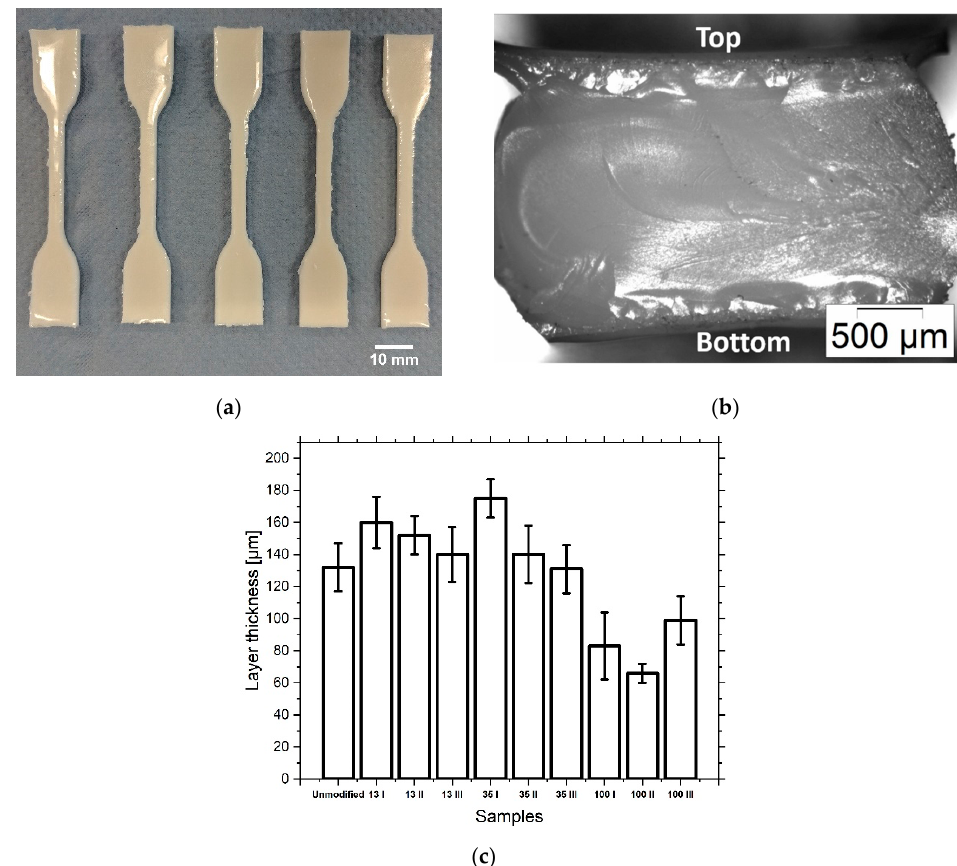
Figure 7. Printed tensile specimens of sample 100 III with 2 vol% fillers of 100 nm size ( a ). Cross-section of the specimen ( b ). The layer thickness of five subsequently printed layers with a UV curing step after their deposition for all printed samples ( c ).